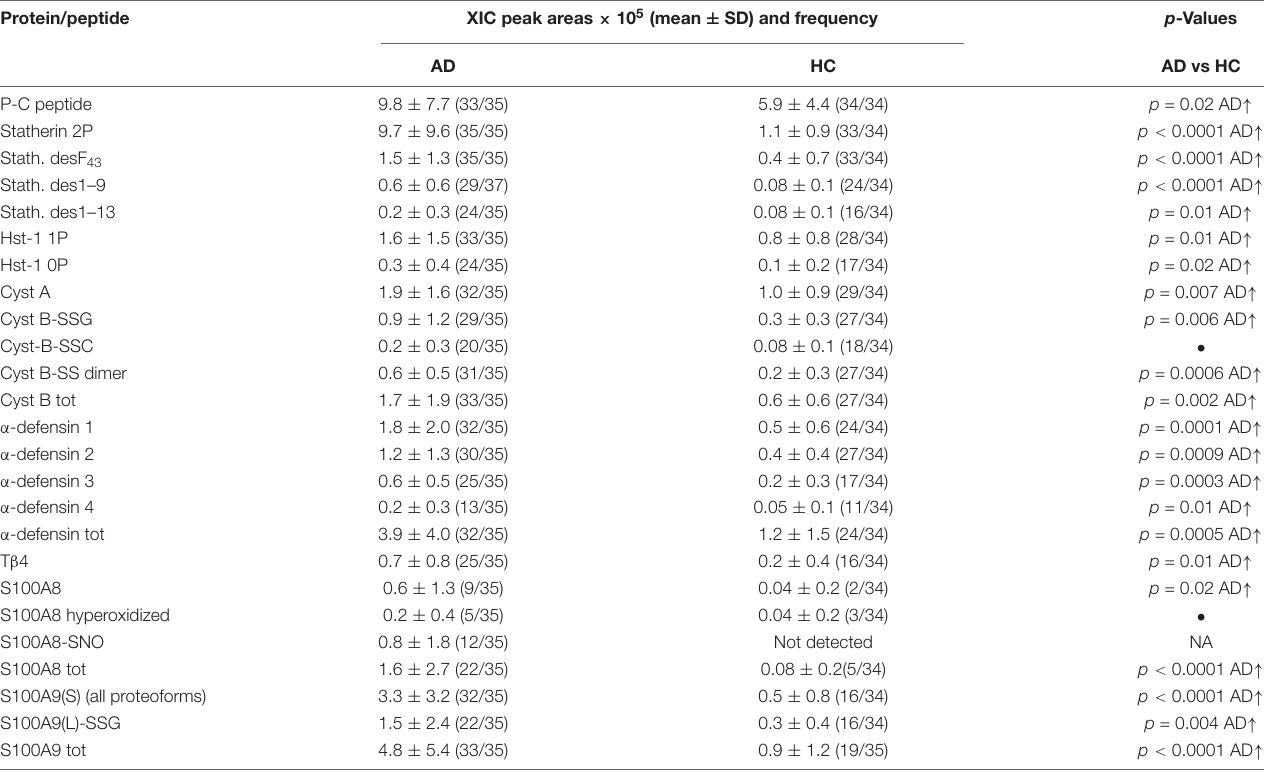
TABLE 1 | XIC peak areas values (mean ± SD) normalized on total protein concentration and frequencies of salivary proteins/peptides resulted to levels significantly different between the AD group and HC group.